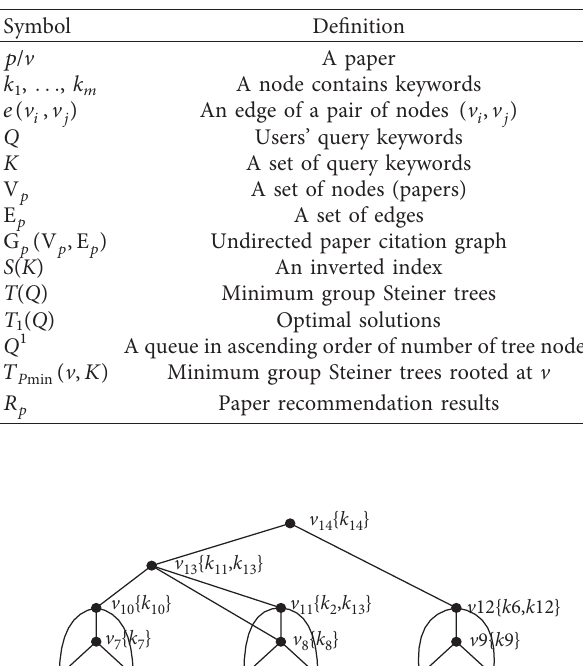
Table 1: Symbol definitions.